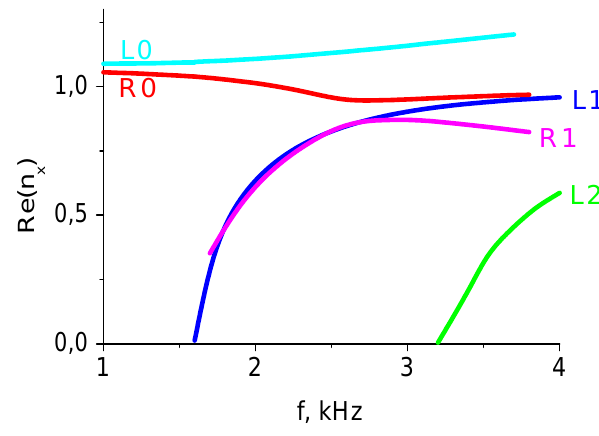
Fig. 6b. X-component of refraction index for different modes.